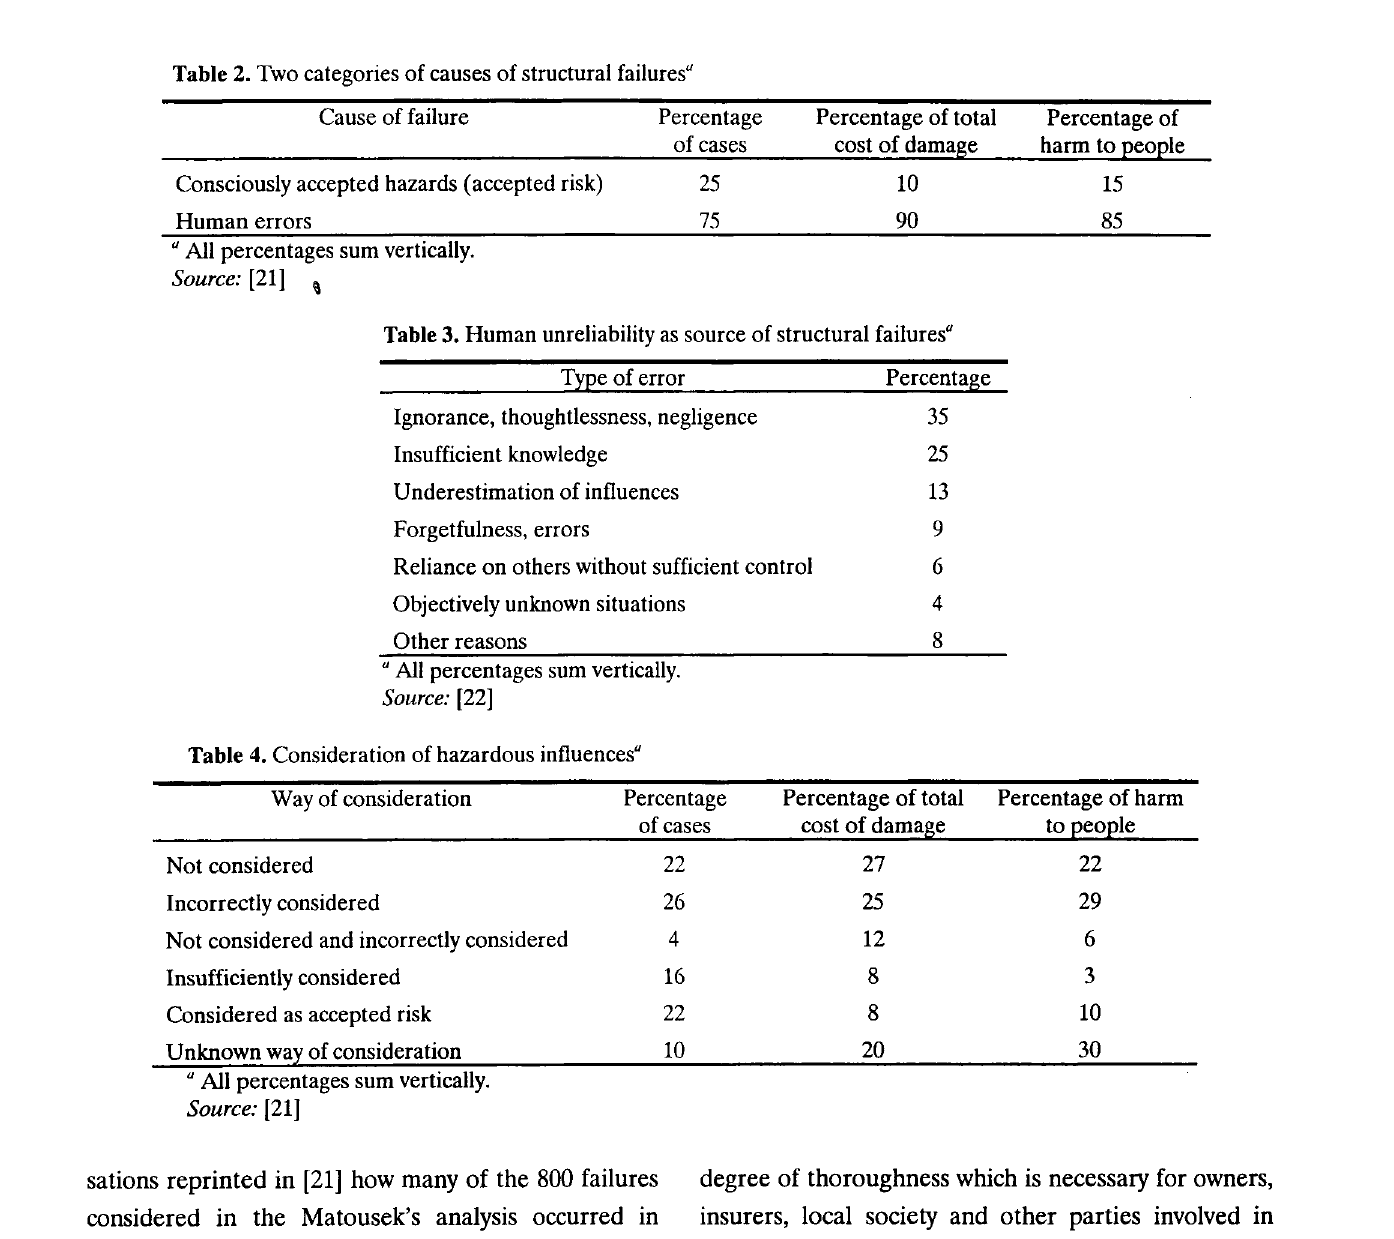
Table 3. Human unreliability as source of structural failures" Type of error